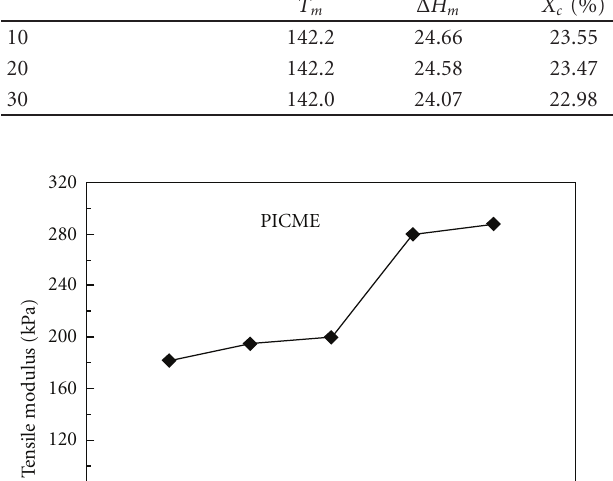
1(e) and 1(f)) which results in fewer amounts of free liquid electrolyte stores in the composite membrane matrix and leads to decrease in ionic